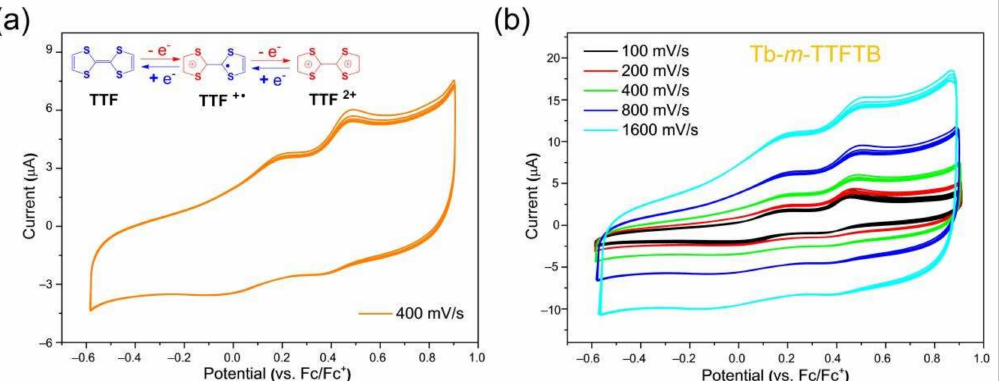
Figure 3. Solid-state cyclic voltammograms of Tb- m -TTFTB performed over five consecutive cycles ( a ) and at different scan rates ( b ). The experiments were conducted in 0.1 M LiBF 4 in CH 3 CN electrolyte. The inset is the redox reaction of the TTF.